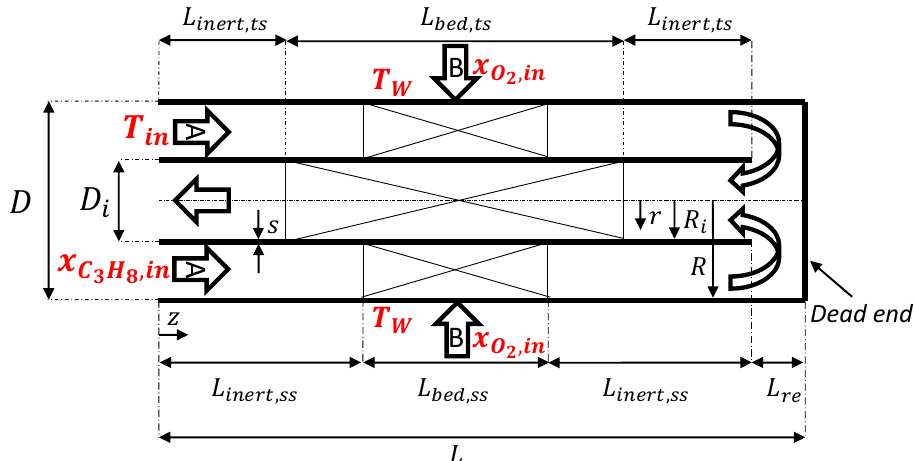
Figure 14. Conceptual design of the heat-integrated packed-bed membrane reactor (PBMRint), including boundary conditions.